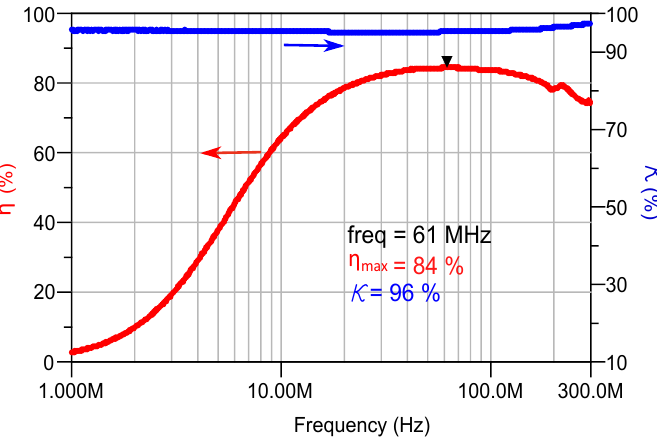
Figure 15. Efficiency and coupling factor of the transformer with PMC core. The sample was made with 10 turns and a turn ratio of 1:1. The composite was made out of 65%